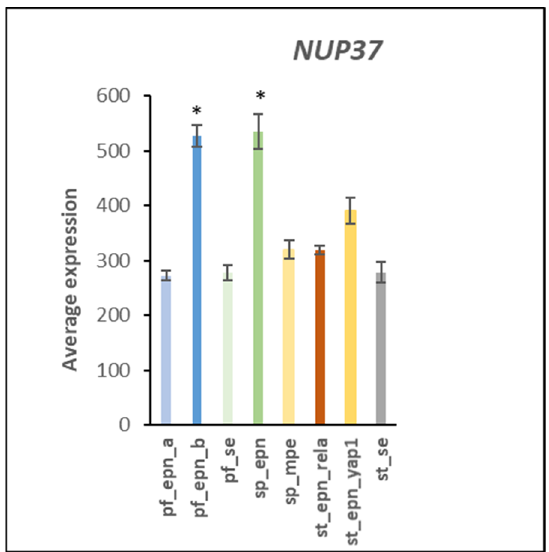
Figure 20. Differential expression of genes encoding E3 ligase adaptors related to the nuclear pore gene NUP37 (by Anova, F = 43.18, p = 7.89 × 10 − 37 ). * PF_EPN_B and SP_EPN means are significantly higher than the other groups by t -test p < 0.01. Dataset GSE64415.